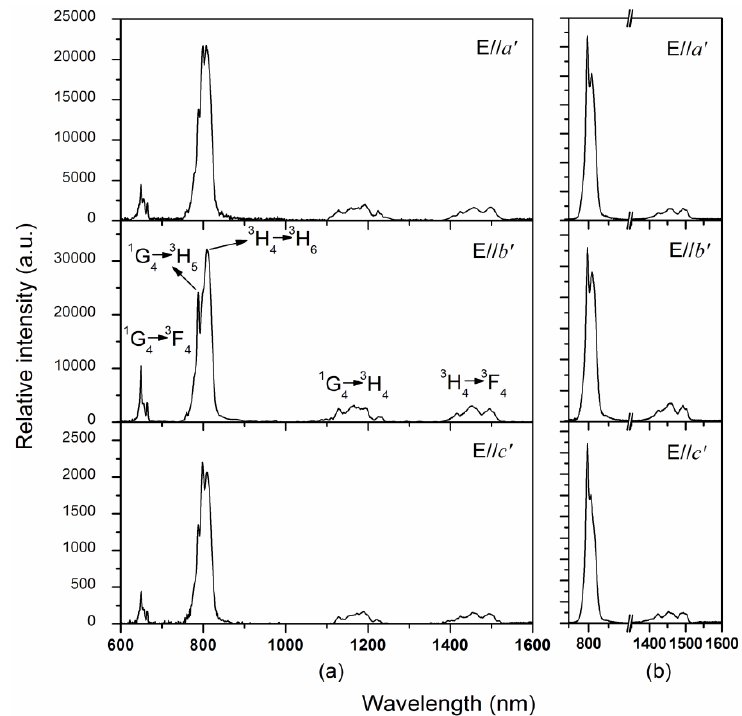
Ba Gd (MoO ) crystal for the 3 2 3 4 8